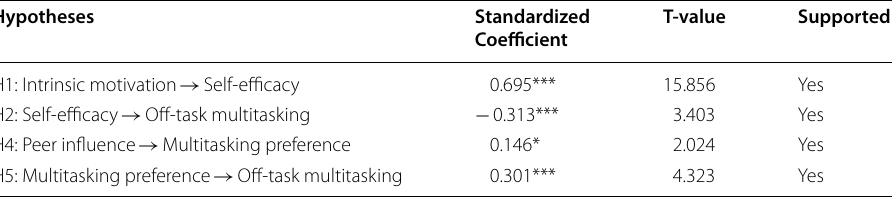
Table 4 Results for the main